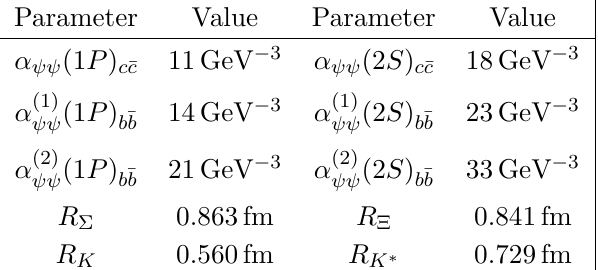
Table 1 . Hadro-quarkonium model. Input values and